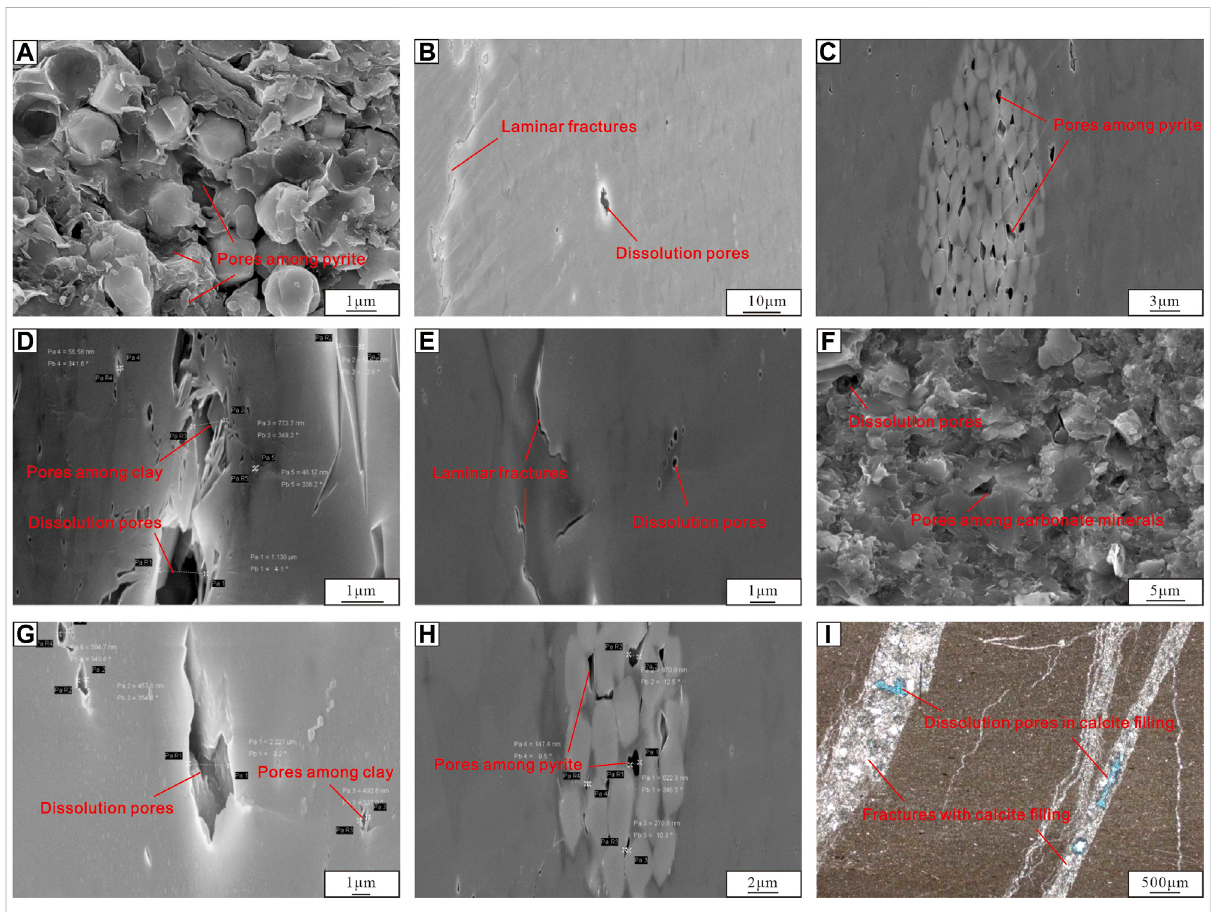
FIGURE 6 Typical pore types found in marl reservoir in the Shulu Sag: (A) , intercrystalline pores of pyrite in laminated marl with SEM observation, ST3, 3,670 m; (B) , laminar fractures and dissolution pores associated with organic bands in laminated marl, ST3, 3,670.89 m; (C) , intercrystalline pores of pyriteinlaminatedmarl,ST3,3,677.05m; (D) ,intercrystallineporesofclaymineralsinlaminatedmarl,ST3,3,978.76m; (E) ,nanoscalebeddingmicro- cracks and dissolution pores in laminated marl, ST3, 3,981.93 m; (F) , intercrystalline pores in the massive marl, ST3, 3,999.38 m; (G) , dissolution pores and intercrystalline pores of clay minerals in the massive marl, ST3, 3,817.65 m; (H) , intercrystalline pores of pyrite in the massive marl, ST3, 3,817.65 m; (I) , local dissolution pores occur in calcite, fi lling in fractures and pore spaces, and they primarily occur concurrently with structural fractures, ST3, 3,983.83